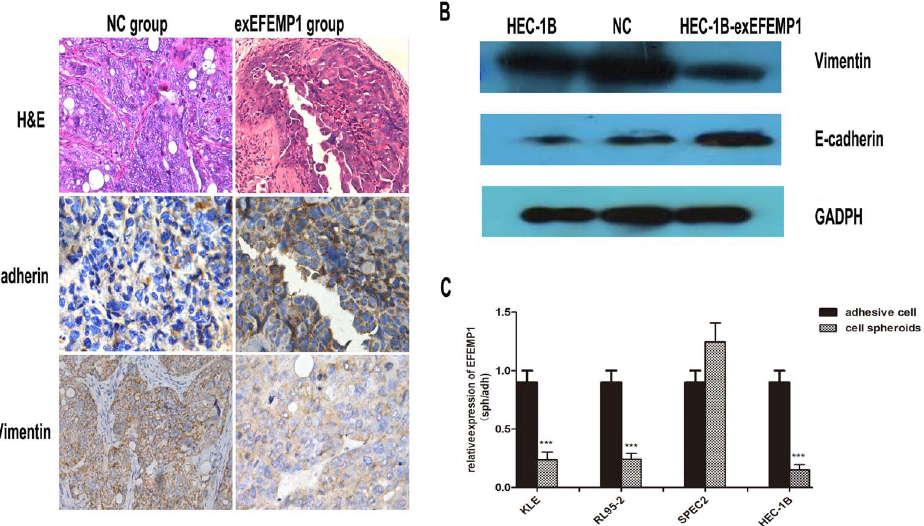
Figure 6. The effect of EFEMP1 on E-cadherin and vimentin expression. A: The nude mouse tumor tissues were paraffin embedded and tumor slides were stained with hematoxylin & eosin ( 6 400), antibody of E-cadherin( 6 400) and vimentin ( 6 400). B: Western immunoblot analysis of the changes in expression of E-cadherin and vimentin in HEC-1B cells transfected with exEFEMP1 and vector. C: Cell spheroids cultured to mimic metastatic cancer cells. qRT-PCR analysis of the changes in EFEMP1 expression in various EC cells. Data are expressed as the mean; bars, 6 SD, and normalized to adherent cells from three independent experiments. ***P , 0.001.